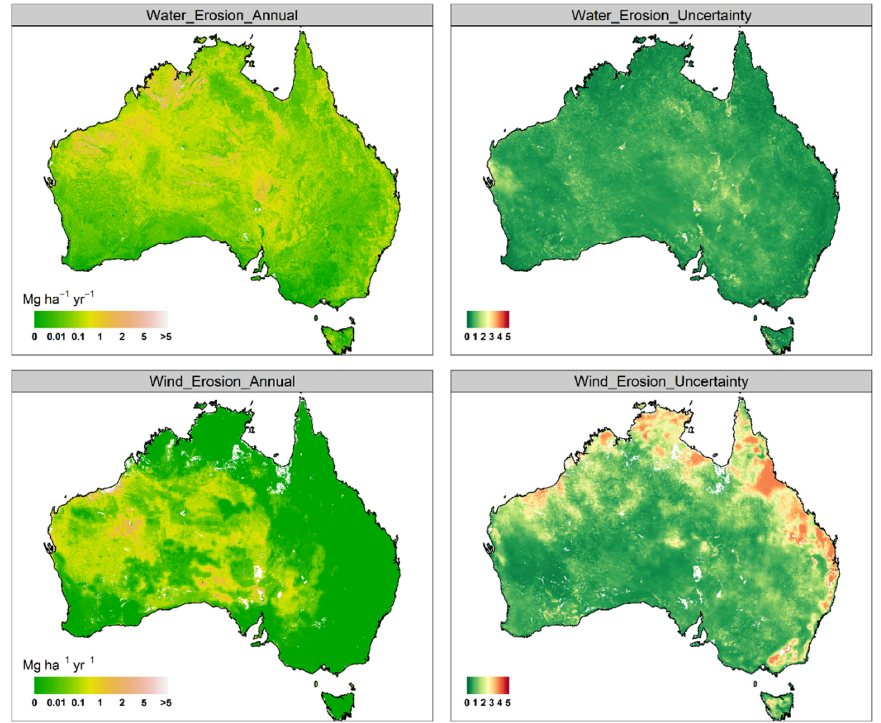
Figure 8. Annual average water and wind erosion and uncertainty based on the RUSLE and RWEQ in 2001–2020.